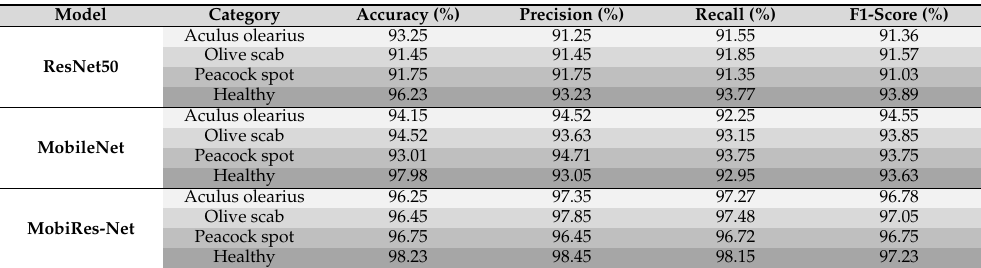
Table 4. Model classification results for the four-category classification task for the original